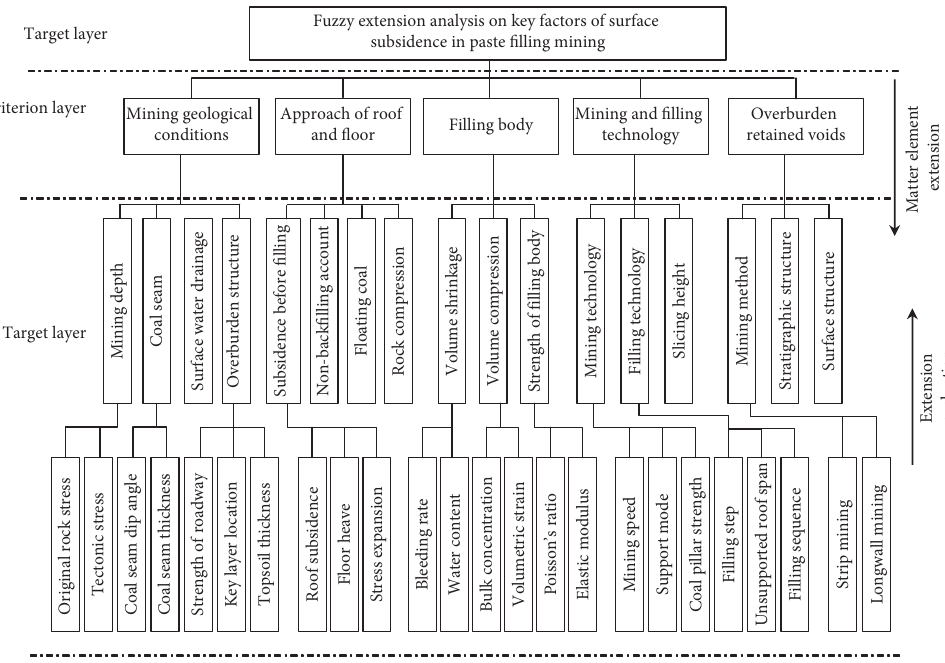
Figure 1: Evaluation index of key factors of surface subsidence in paste backfilling mining. Table 1: Point